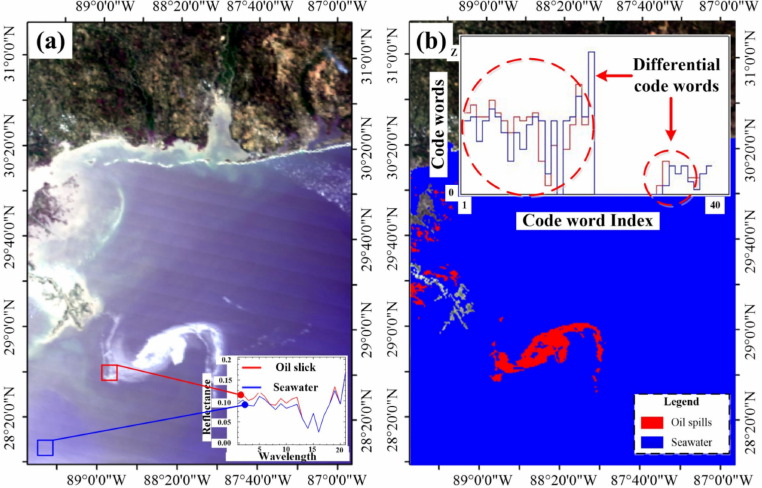
Figure 8. The experimental data 4 (( a ), captured by the Terra satellite) and its crude oil leakage detection results produced by the MSE method with SSI ( b ). Differential code words could be observed in the red